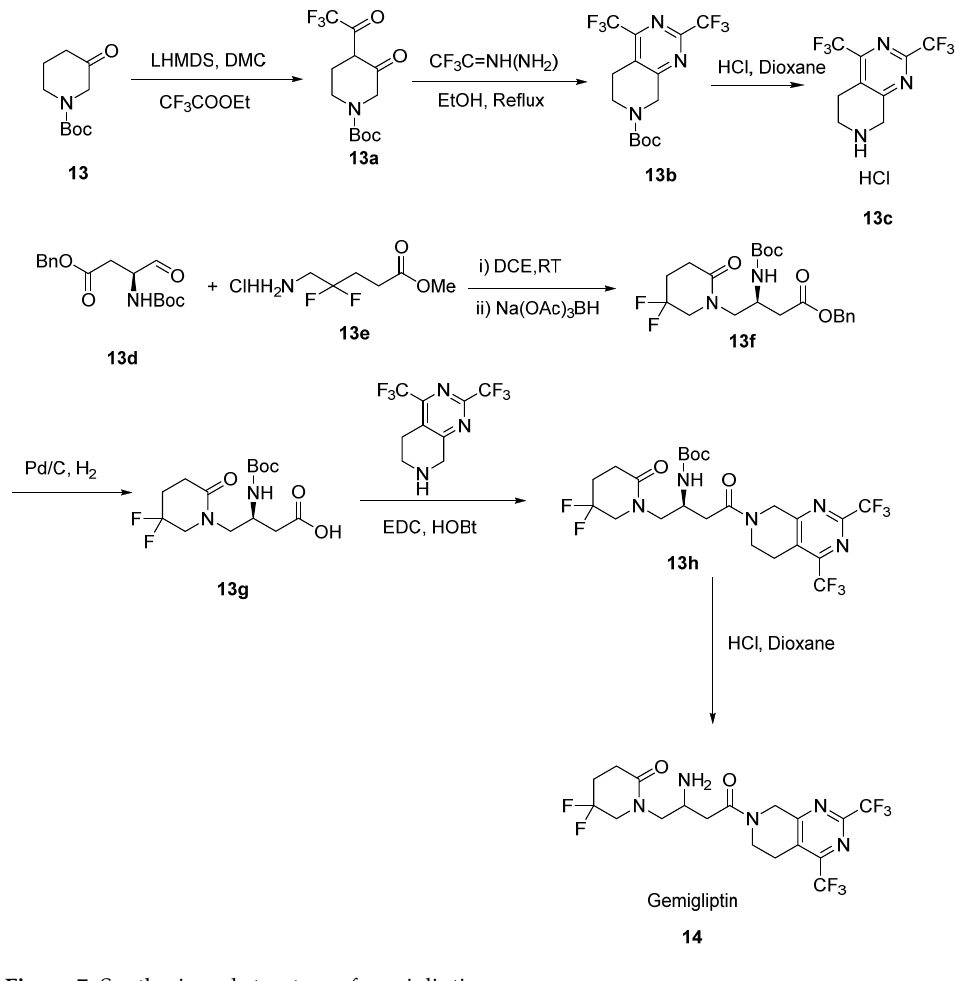
Figure 7. Synthesis and structure of gemigliptin.